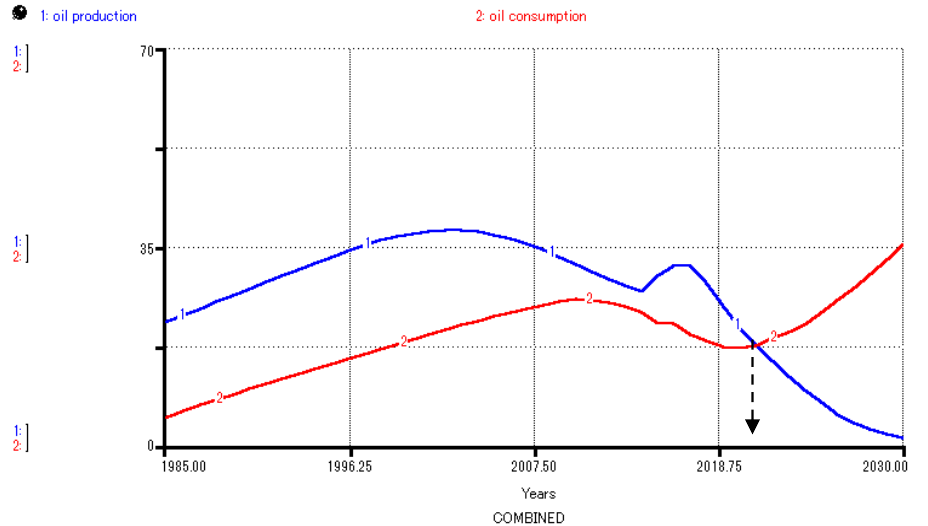
Figure 21. Oil production and consumption in combined